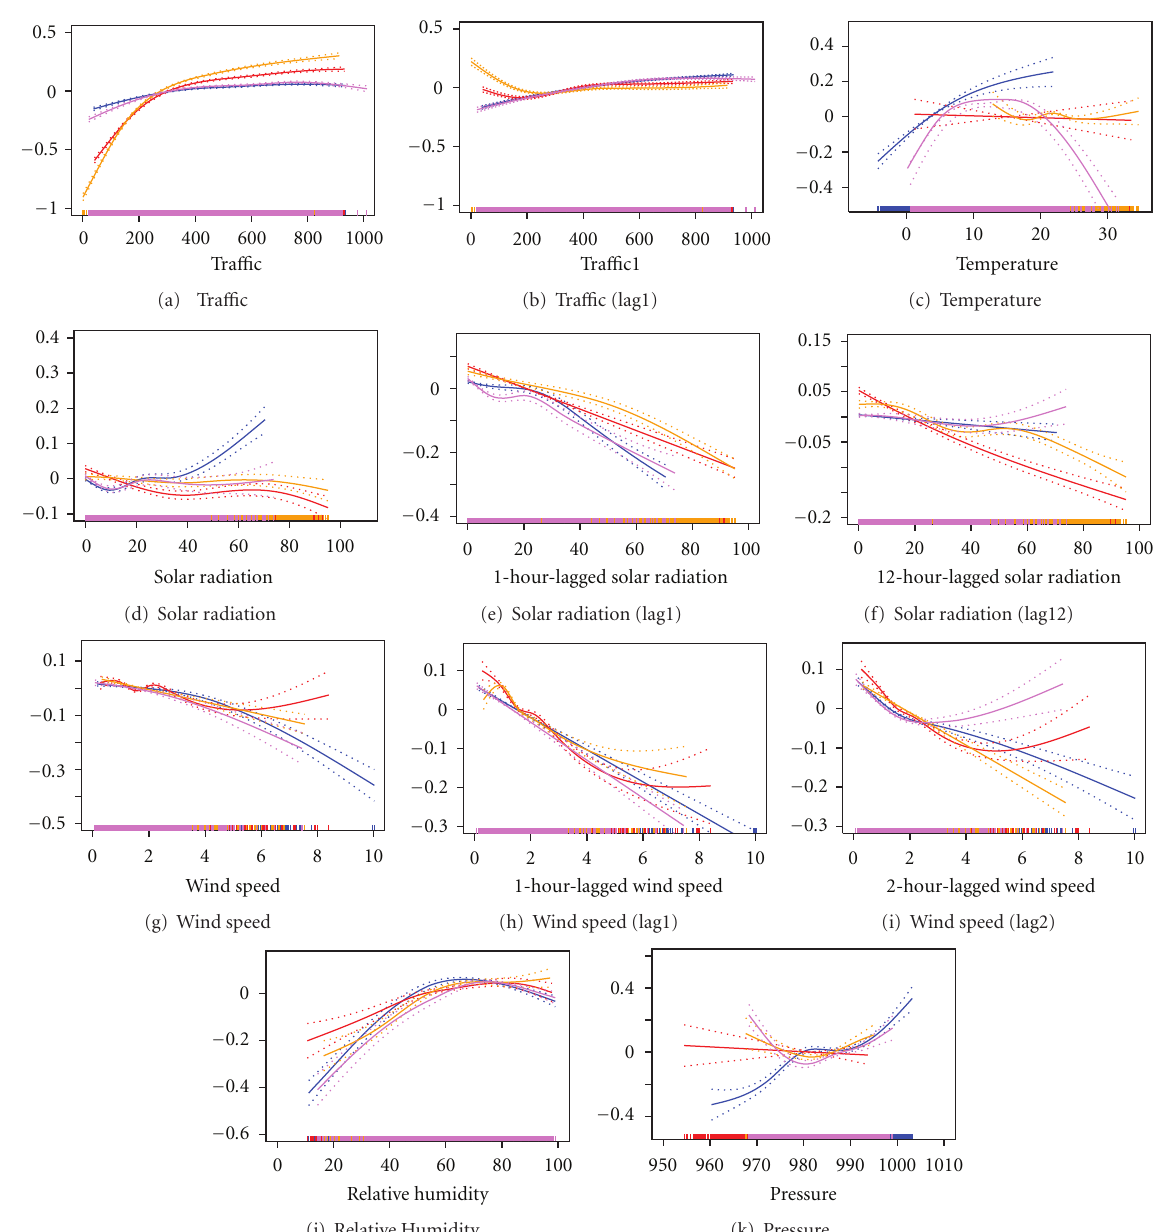
Figure 7: Estimated e ff ects of tra ffi c and meteorological variables for NO 2 during di ff erent seasons. Blue is Winter, red is Spring, orange is Summer, and violet is